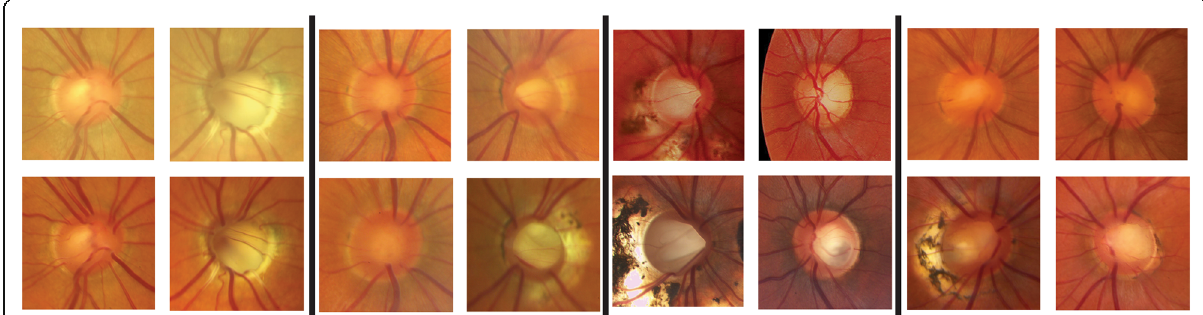
Fig. 2 Optic nerve photographs of individuals affected by cavitary optic disc anomaly. Each group of four images (separated by black bars) represents one affected individual. In each group of four, the right eye images are displayed in the first column, left eye images are displayed in the second column, baseline images are displayed in the top row, and follow up images are displayed in the bottom row. Left, individual III.8 at baseline and at 3 year follow up. Second from left, individual IV.2 at baseline and at 2 year follow up. Third from left, individual V.2 at baseline and at 9 year follow up. Right, individual IV.4 at baseline and at 9 year follow